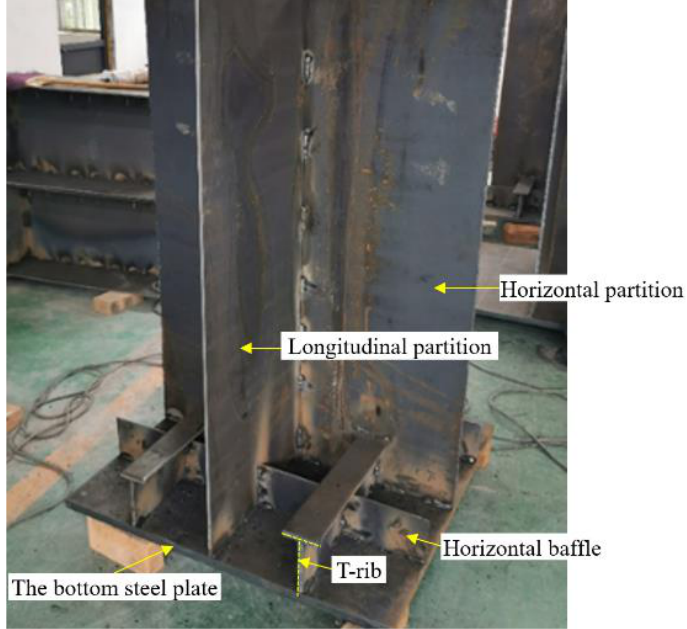
Figure 5. Construction of the steel shell inside the member.